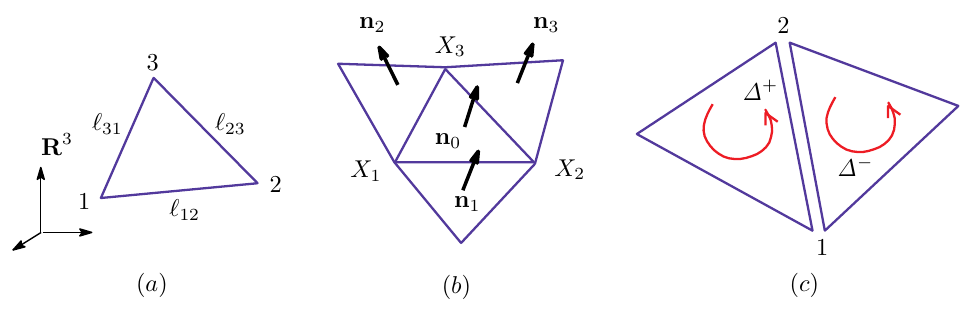
Figure A1. ( a ) A triangle ∆ included in a triangulated sphere in (cid:60) 3 ; ( b ) the three nearest neighbor triangles of ∆ and the unit normal vectors n 0 , n 1 , n 2 and n 3 ; and ( c ) the triangle orientation that defines the direction-dependent bond potential γ 12 (cid:96) 2